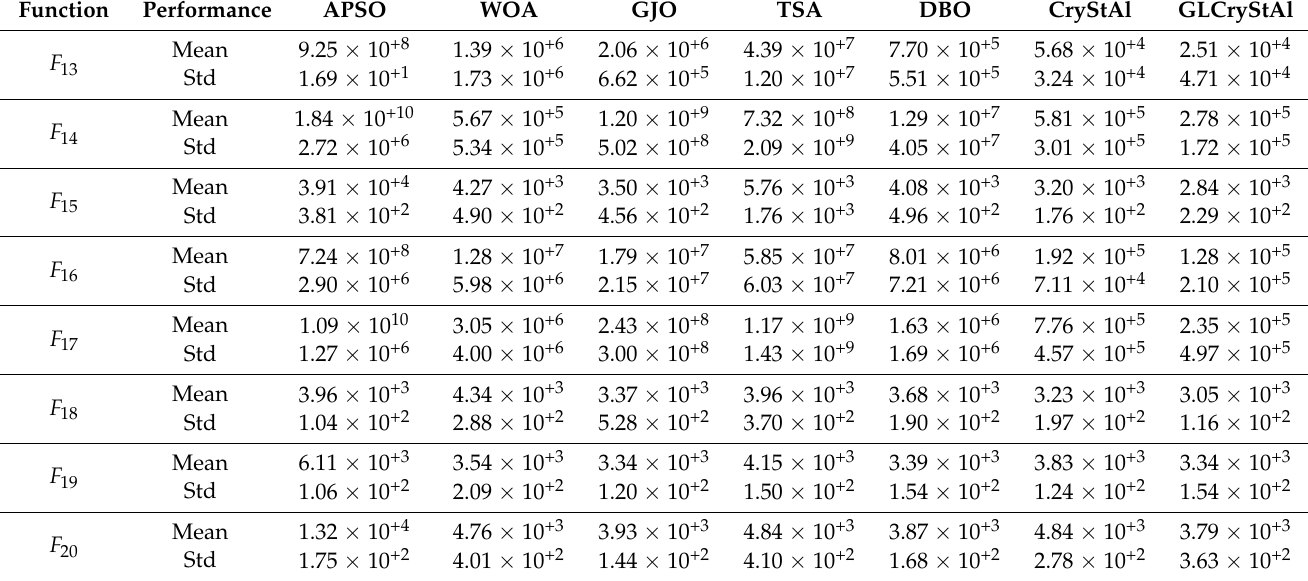
Table 5. Test results of CEC2017